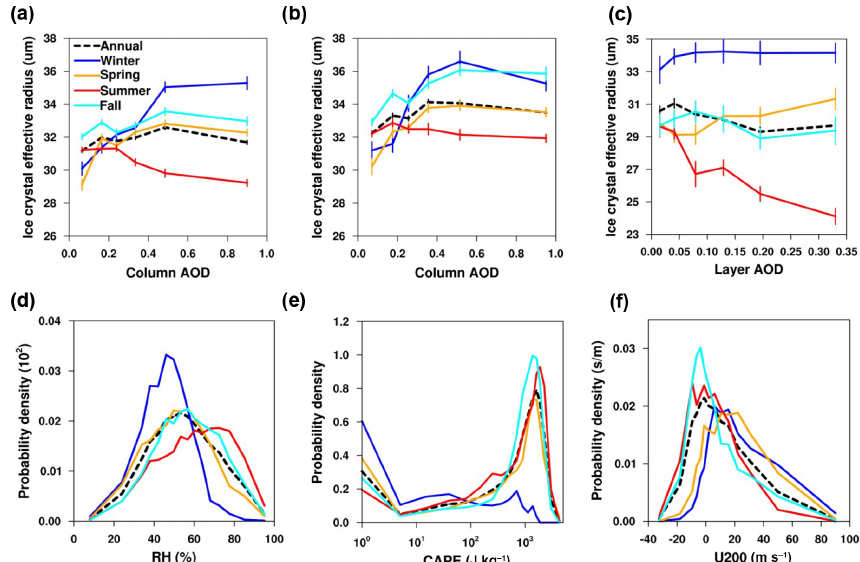
Figure 4. Changes in R ei with AOD and the probability distribution of selected meteorological parameters as a function of season. (a– c) Changes in R ei with AOD as a function of season for (a) all ice clouds, (b) convection-generated ice clouds, and (c) in situ ice clouds. (d–f) The probability distribution of (d) RH 100 − 440hPa , (e) CAPE, and (f) U200 as a function of season. Definitions of season are as follows: and November. The definition of error bars is the same as in Fig. 1. The total numbers of samples used are 5 . 68 × 10 4 (a, d–f) , 2 . 73 × 10 4 (b) , and 1 . 09 × 10 4 (c)